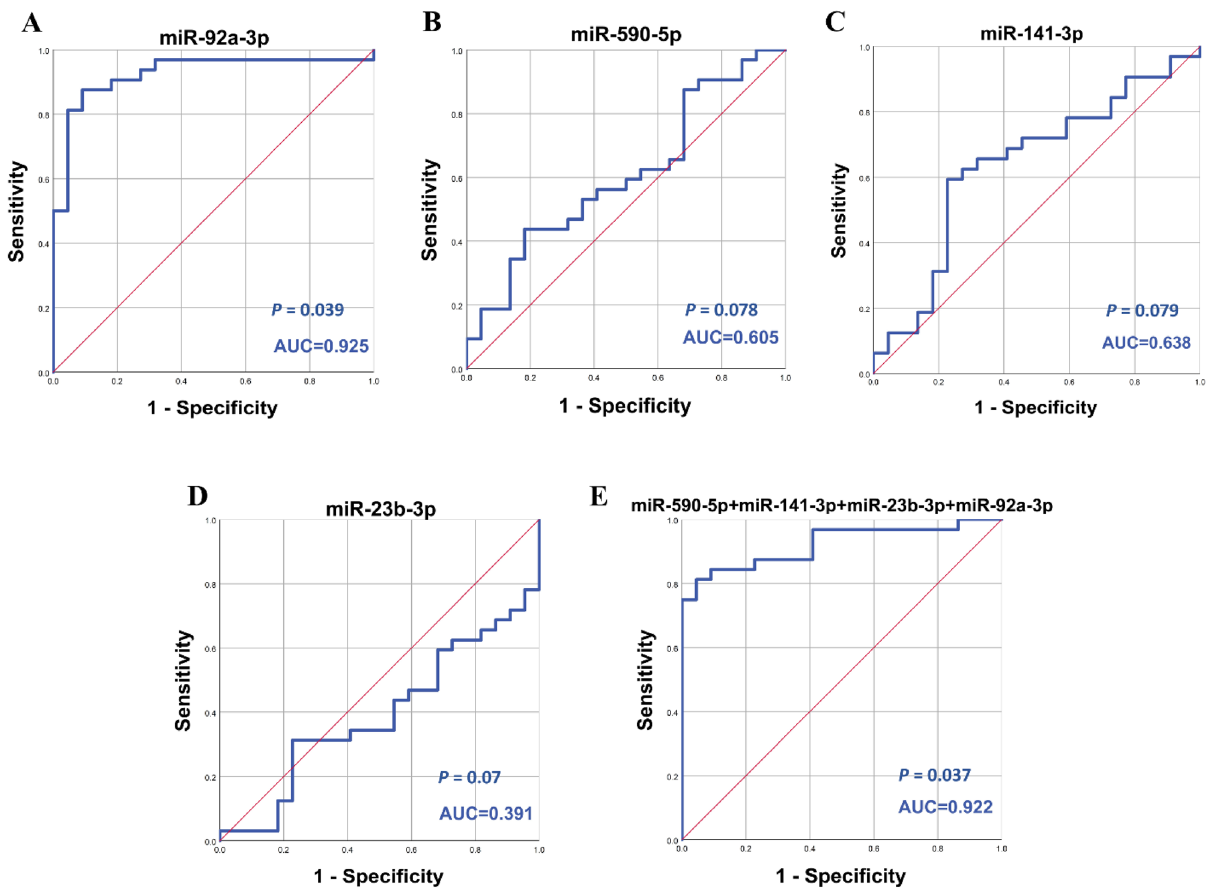
Figure 10. Diagnostic performance of model 2 on the validation dataset (GSE41922). ROC curve analysis of ( A–D ) miR-23b-3p, miR-590-5p, miR-141-3p and miR-92a-3p in BC patients versus healthy controls. ( E ) the combination of the four miRNAs in BC patients versus healthy controls.